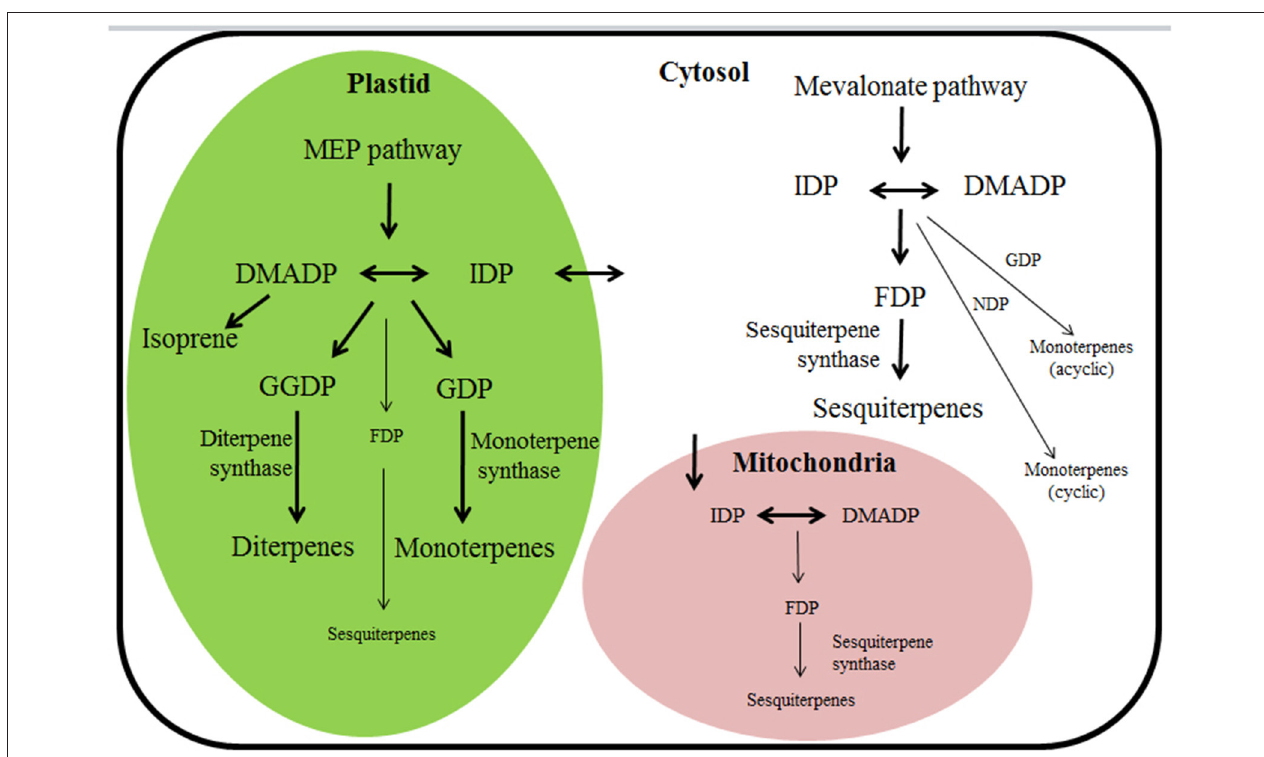
FIGURE 1 | Terpene biosynthetic pathways and their subcellular compartmentalization in plants. Thick arrows denote the classical understanding of terpenoid synthesis compartmentalization among cytosol and plastid (Bohlmann et al., 1998b; Chen et al., 2011; Tholl and Lee, 2011), reflecting the circumstance that monoterpene and diterpene synthases harboring a chloroplast-targeting peptide are functionally active in plastids and sesquiterpene synthases lacking the target peptide are active in cytosol. However, recent findings of the capacity for multi-substrate use of several mono, sesqui-, and, diterpene synthases suggest that when substrate becomes available, several cytosolic “sesquiterpene” synthases could also operate as monoterpene synthases, and analogously, multi-substrate “monoterpene” and “diterpene” synthases could operate as sesquiterpene synthases in plastids (denoted by thin arrows). In addition, terpenoid synthesis can also potentially occur in mitochondria ( Nagegowda, 2010; Tholl and Lee, 2011; Dong et al., 2016). For instance, targeting linalool/( E )-nerolidol synthase (FaNES1) from Fragaria ananassa ( Table 1 for protein specifics) to the mitochondria led to the production of ( E )-nerolidol and homoterpene 4,8-dimethyl nona-1,3,7-triene (DMNT) in transgenic Arabidopsis thaliana plants (Kappers et al., 2005). DMADP, dimethylallyl diphosphate (C5); MEP pathway, 2-C-methyl-D-erythritol 4-phosphate/1-deoxy-D-xylulose 5-phosphate pathway; IDP, isopentenyl diphosphate (C5); FDP, farnesyl diphosphate (C15); GDP, geranyl diphosphate (C10); GGDP, geranylgeranyl diphosphate (C20); NDP, neryl diphosphate